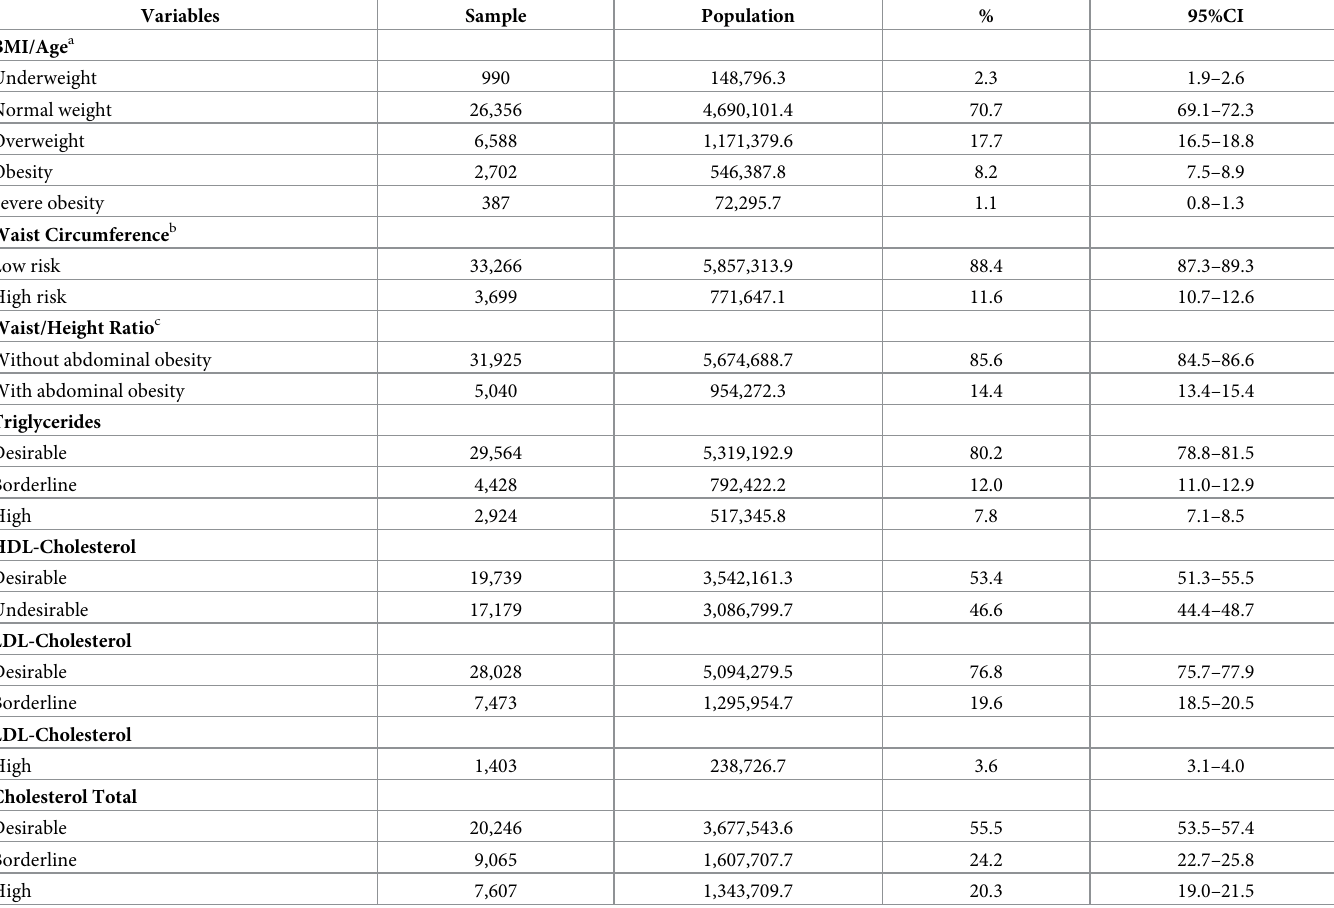
Table 3. Description of anthropometric and biochemical characteristics of Brazilian adolescent students. ERICA Study,